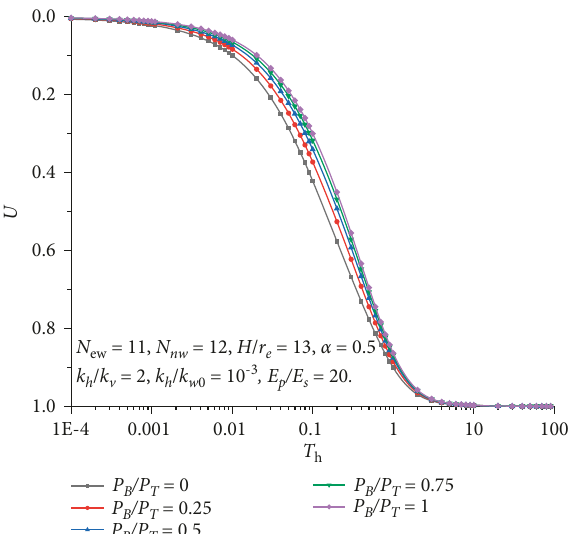
P B / T variation on the consoli-